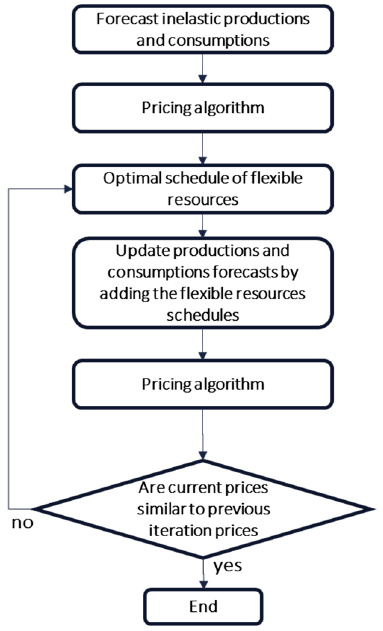
Figure 7. Iterative pricing algorithm with flexible resources.